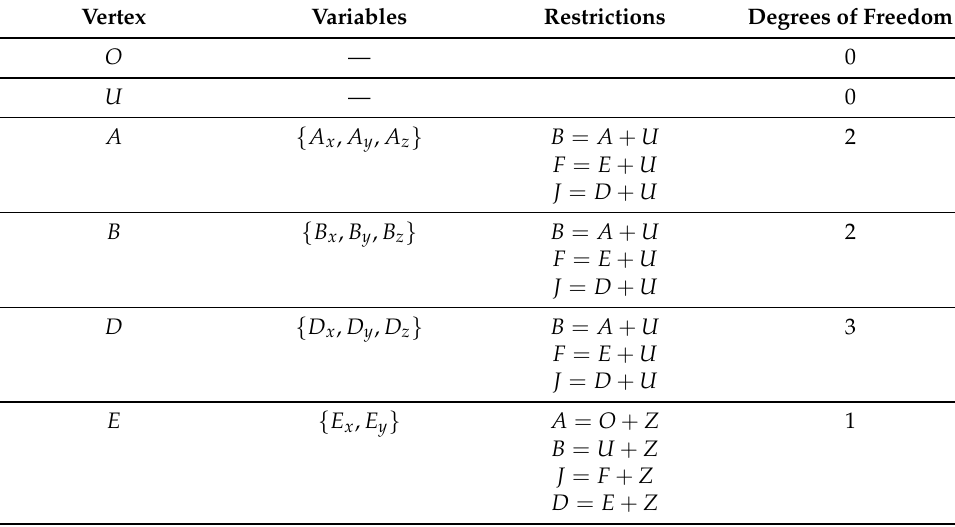
Table 1. Degrees of freedom of the vertices of the